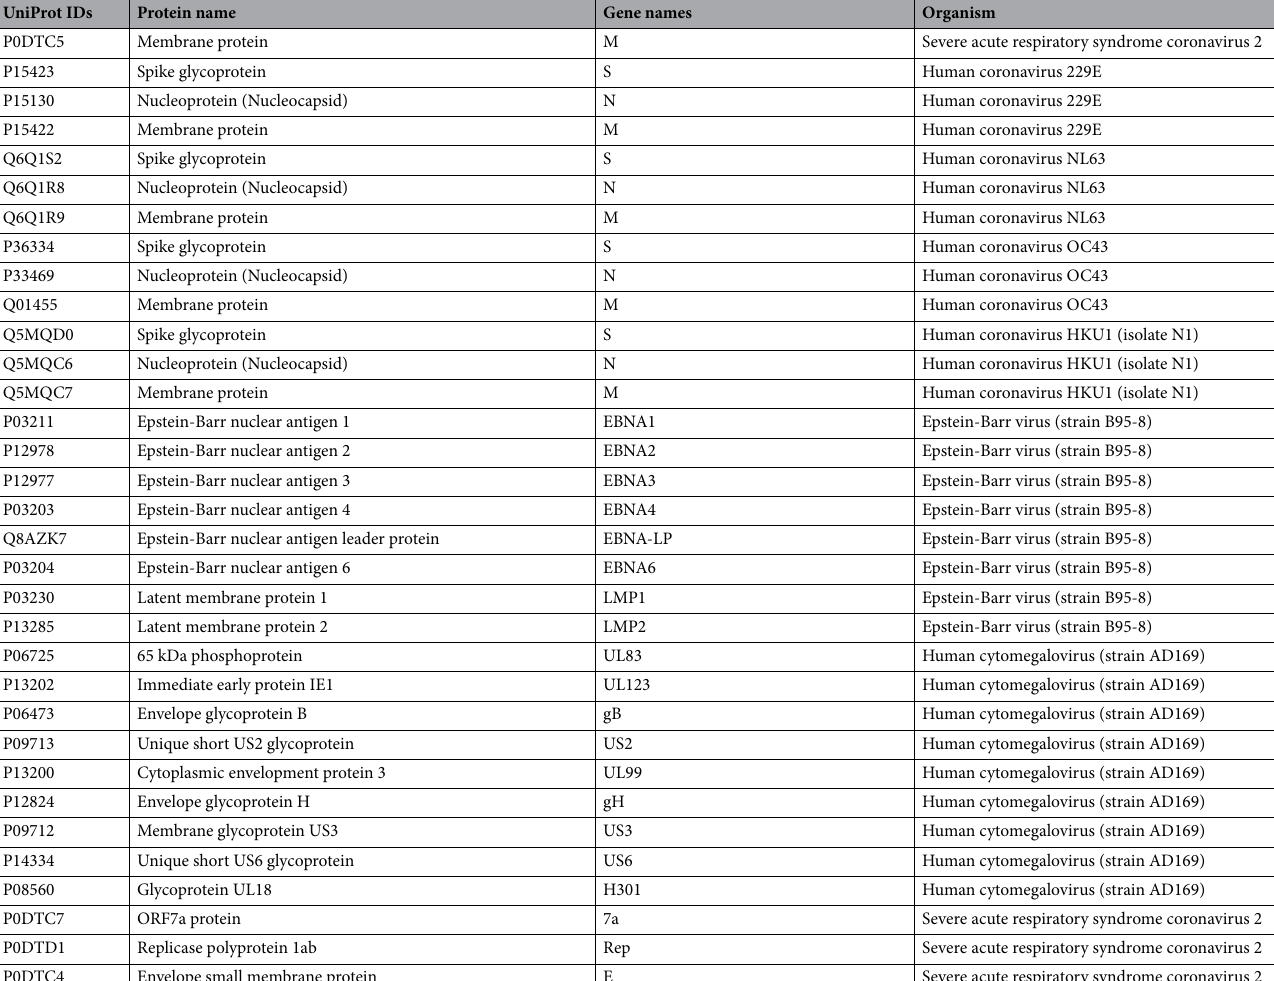
Table 1. List of proteins used in this analysis. Briefly, MS-associated proteins were compiled using the IEDB (see Methods for full methodology on protein selection). This was to ensure that proteins utilized in